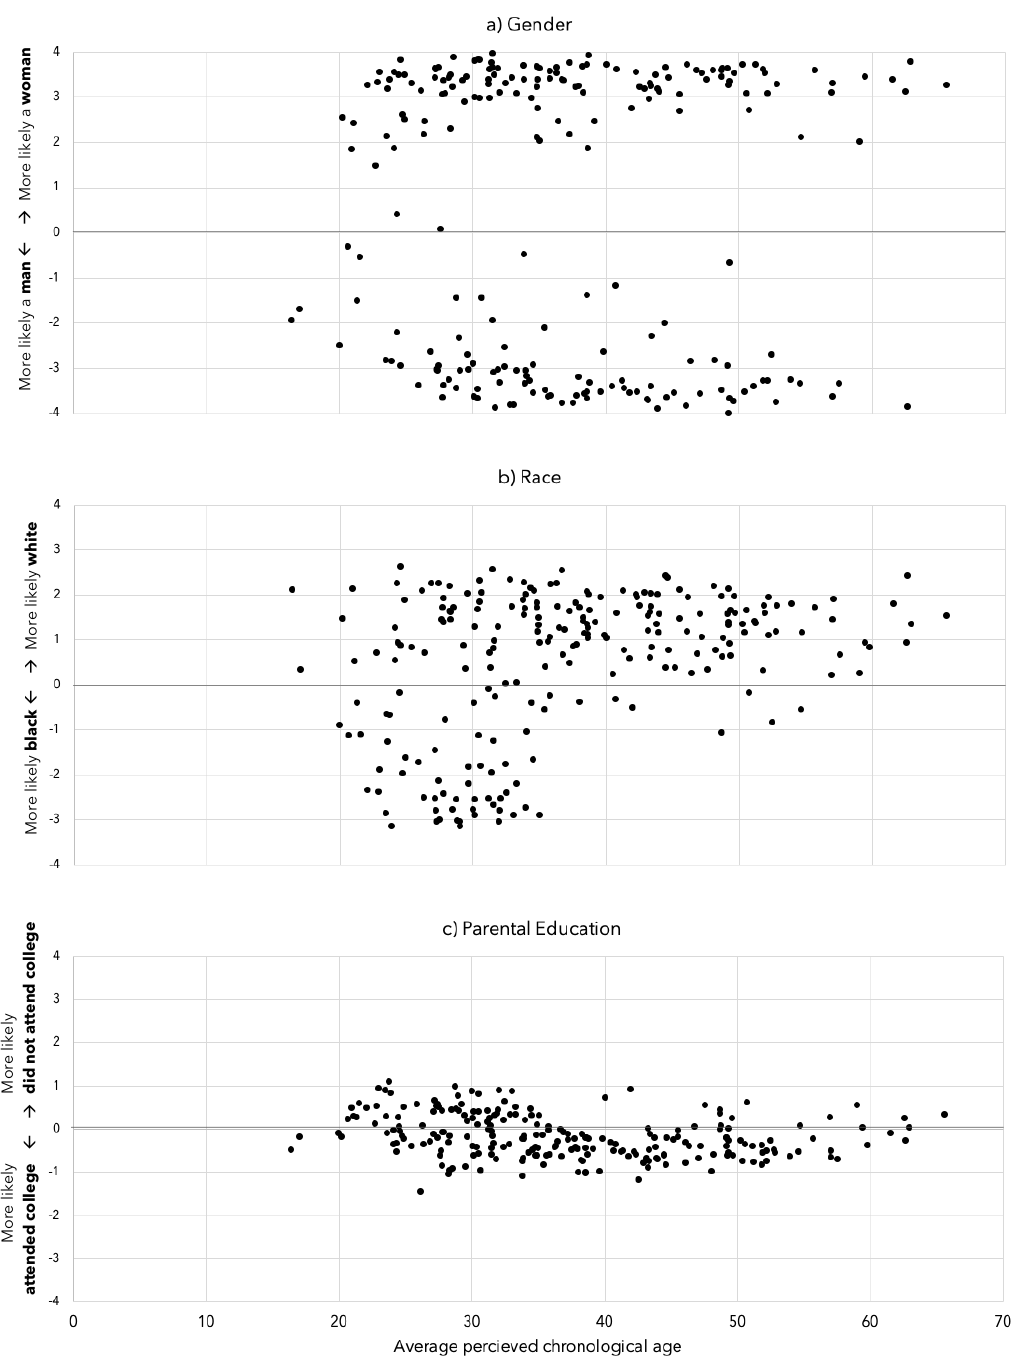
Figure 1: Chronological age perceptions by a) gender, b) race, and c) parental education perceptions of 228 names. The y-axis of each is the average difference in reported likelihood that the name belongs to a person in each category.